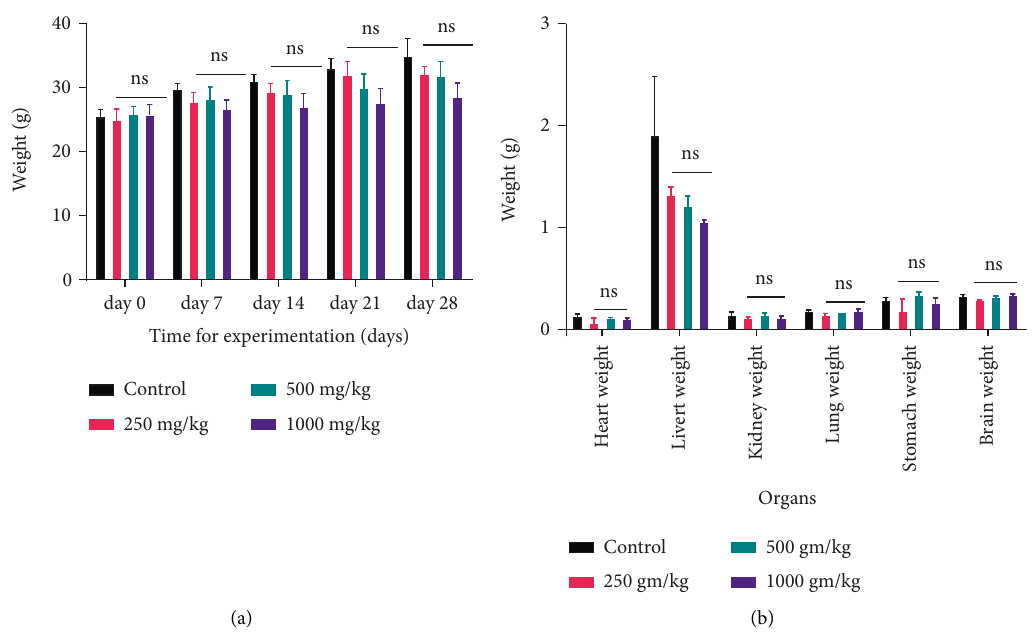
Figure 3: Effect of the methanol extract of A. philoxeroides on (a) body weight and (b) relative organ weight. Data are presented as the mean ± standard deviation ( n � 6). No significant difference was calculated for tests in the A. philoxeroides methanol extract (250 mg/kg, 500mg/kg, and 1000mg/kg) treated groups compared to control were compared with the control group ( p < 0 . 05) using one-way ANOVA followed by Dunnett’s multiple comparison. Here, ns �